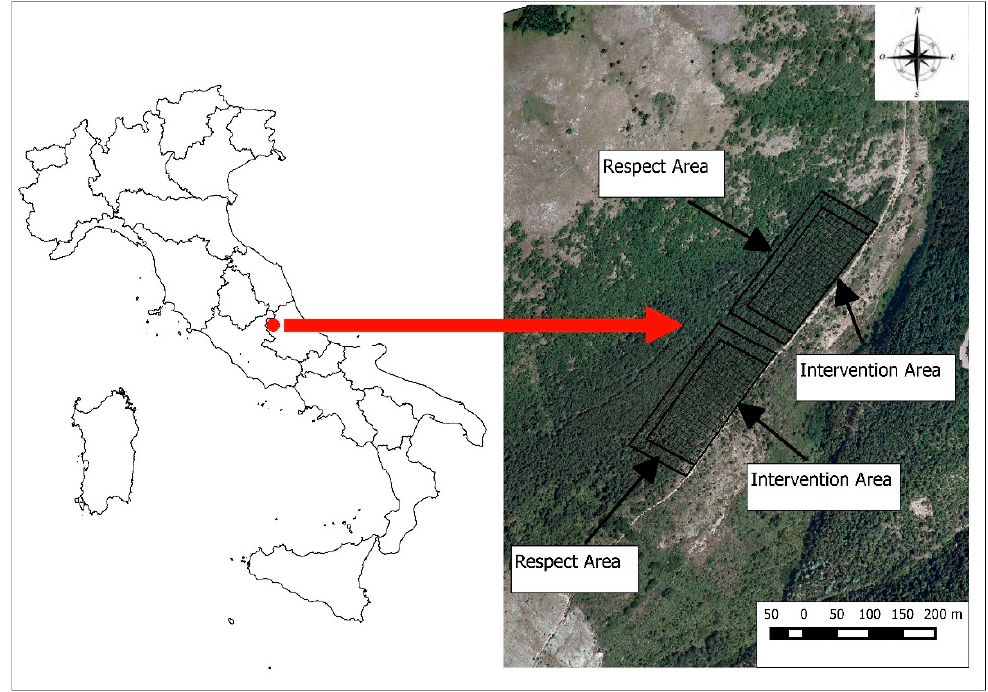
Figure 1. Geographical information and detailed scheme of the treatment area.